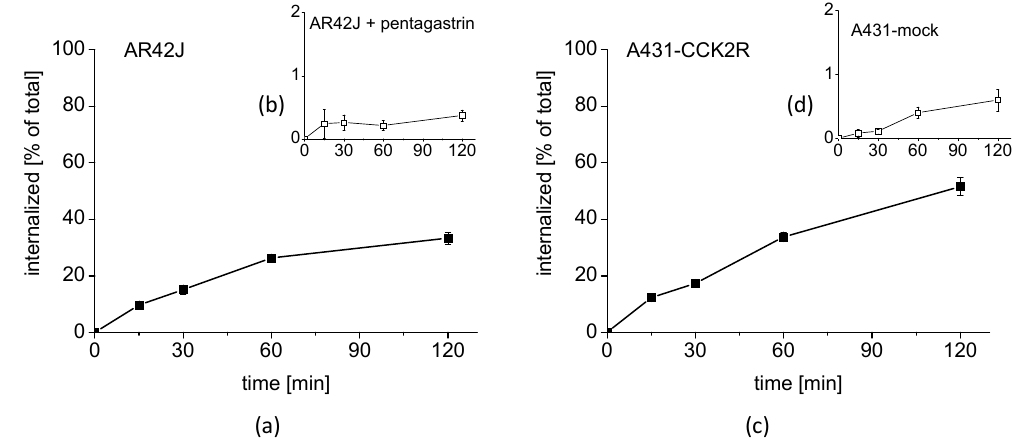
Figure 5. Cell uptake of 68 Ga-DOTA-MGS5 in ( a ) AR42J cells and ( b ) AR42J cells co-incubated with pentagastrin, as well as ( c ) A431-CCK2R cells and ( d ) A431-mock cells for up to 2 h after incubation.